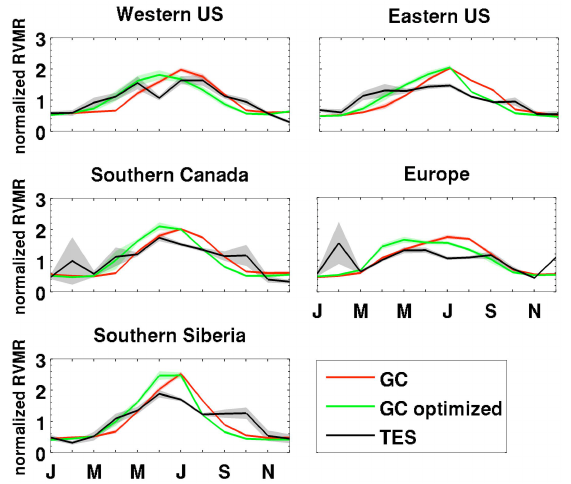
Fig. 9. Seasonal cycle in atmospheric methanol over midlatitude re- gions as measured by TES (black, for DOFS > 0.5) and predicted by the GEOS-Chem base-case (red) and optimized (green) simu- lations. Data are for 2009 and are normalized by the annual mean in each case. Lines show the mean for each region (Fig. S2), while shaded areas indicate the standard error about the mean.